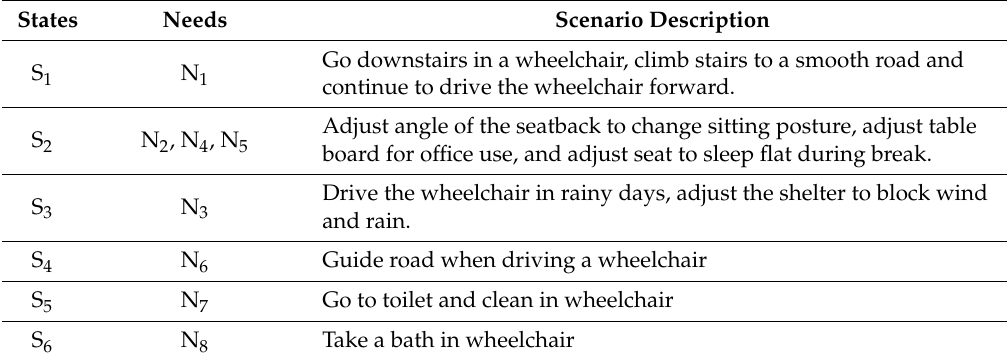
Table 6. Scenario description of six states.